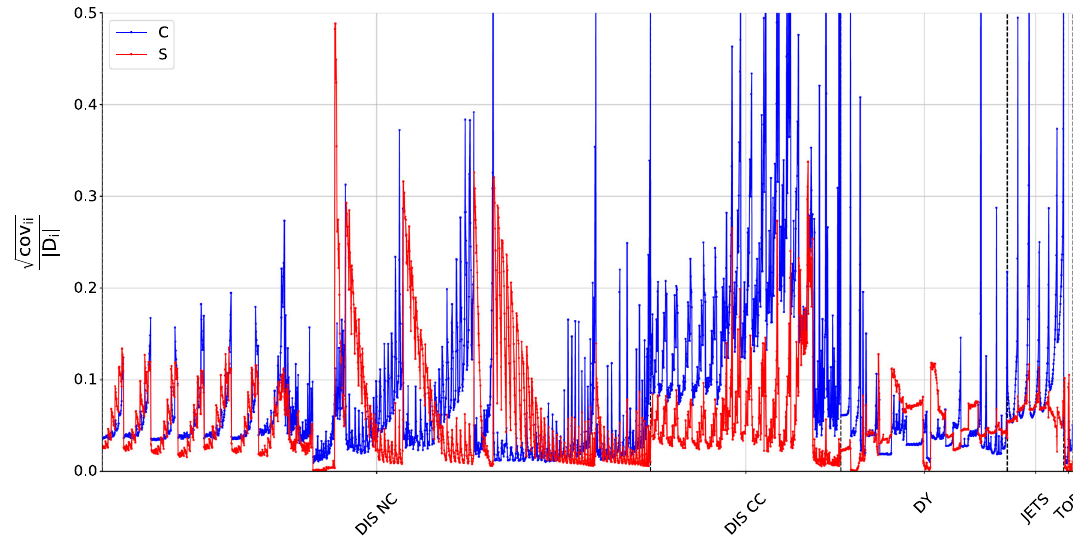
data are grouped by process and, within a process, by experiment, fol- lowing Table